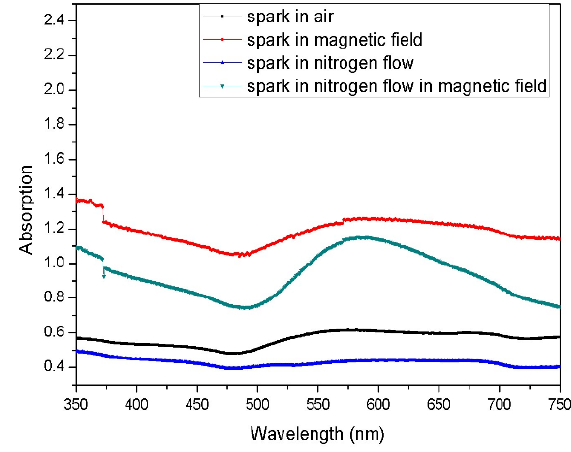
Figure 2. UV–vis absorption spectra of gold nanoparticles.